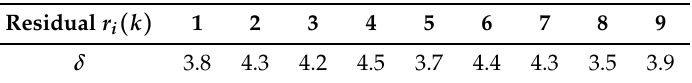
Table 6. Optimal value of the parameter δ .